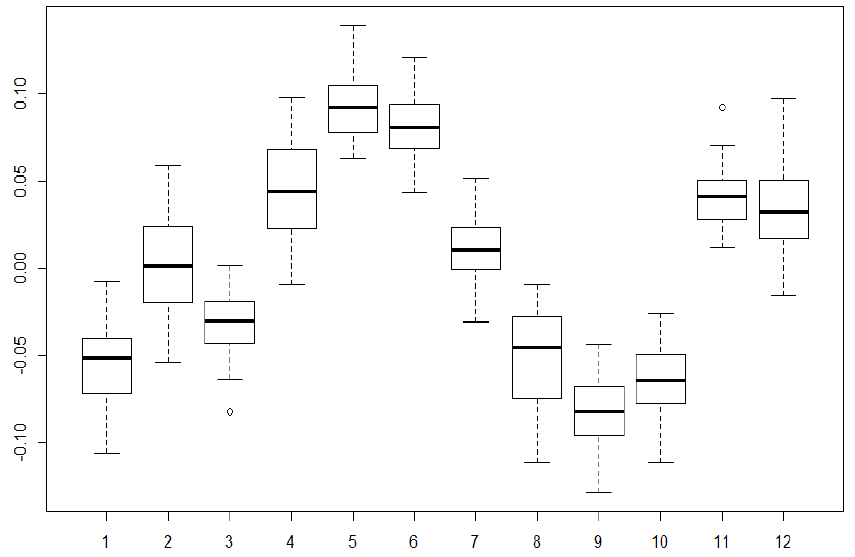
Figure 5. The boxplots from January to